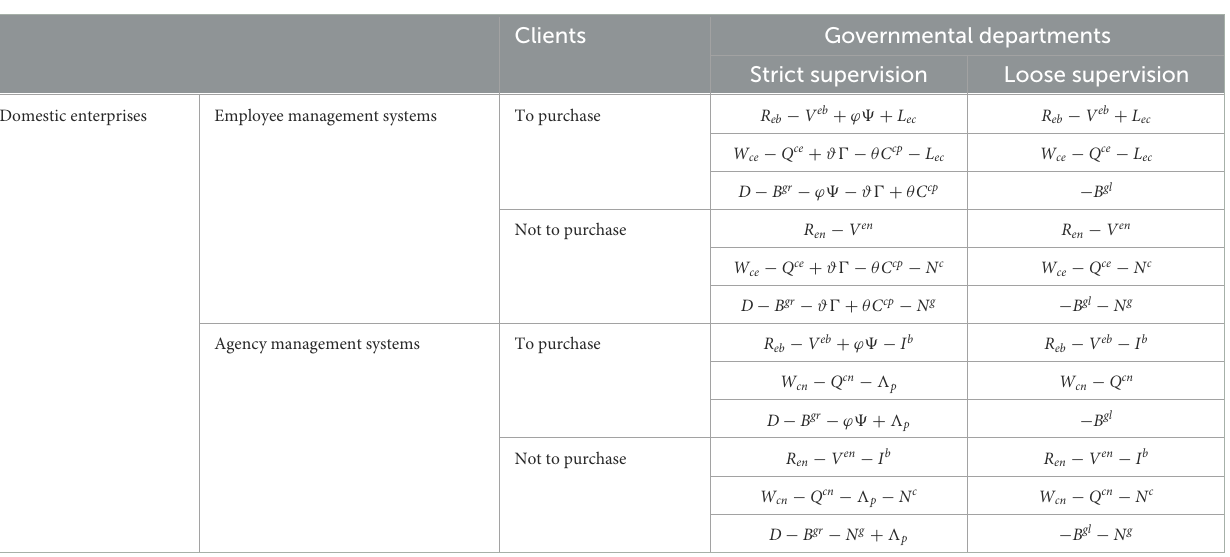
TABLE 2 Payoff matrix of three